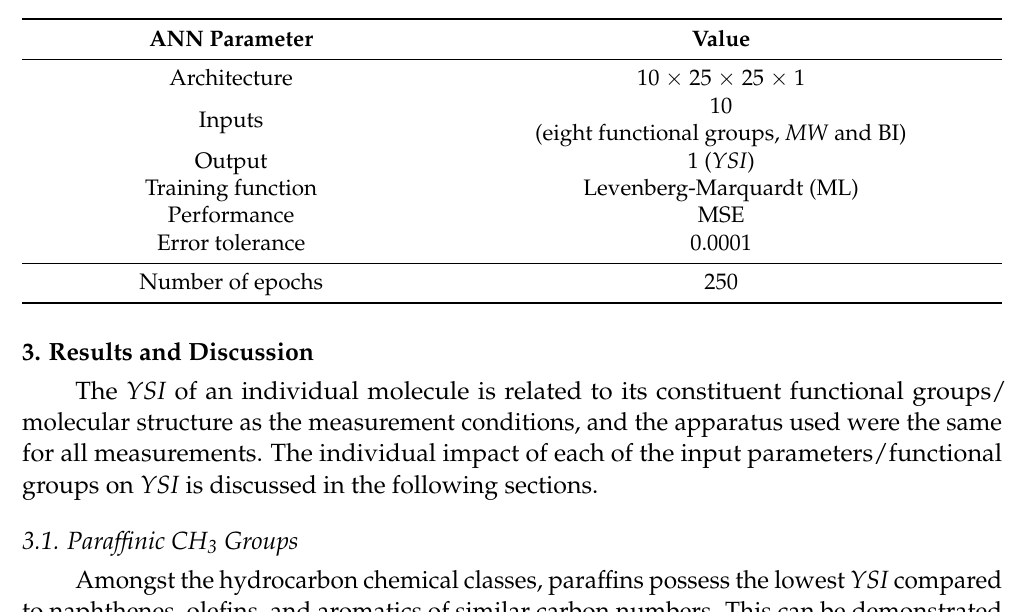
Figure 2. Topology of the ANN model. Table 1. ANN parameters employed for model development.